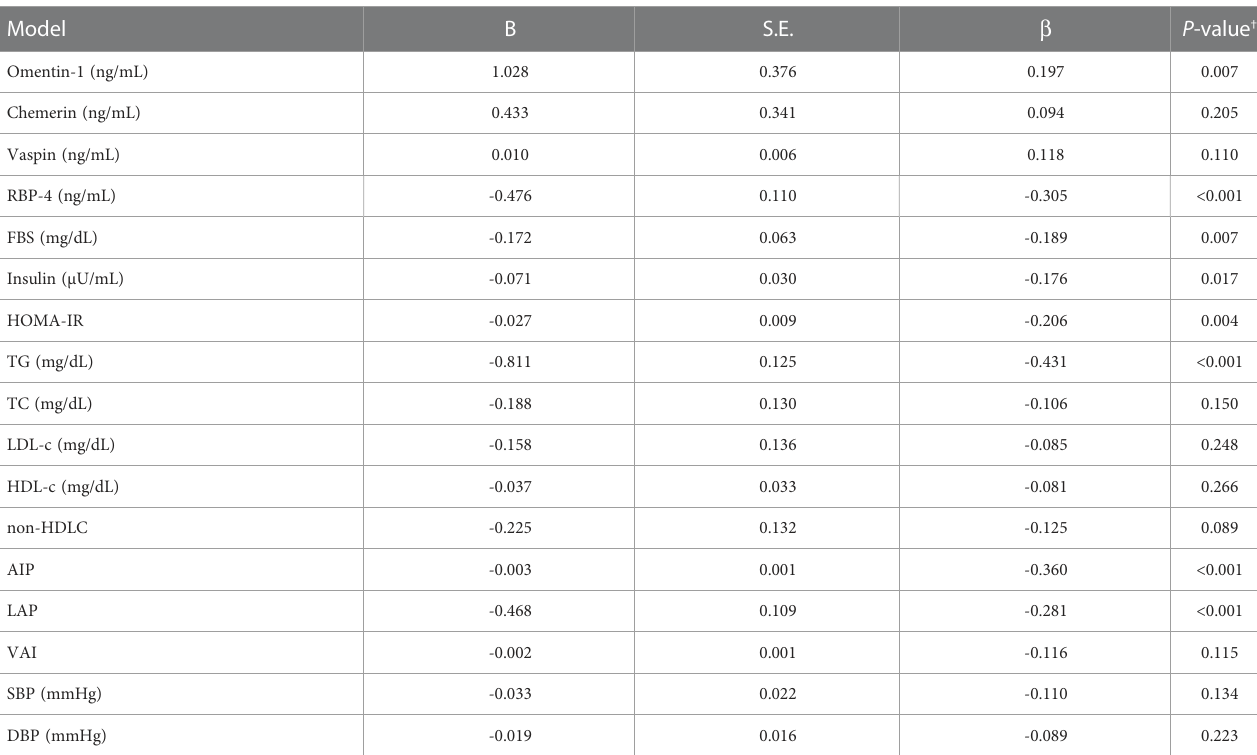
RBP-4, retinol binding protein 4; FBS, fasting blood sugar; HOMA-IR, homeostasis model assessment of insulin resistance; TG, triglyceride; TC, total cholesterol; LDL-c, low-density lipoprotein cholesterol;HDL-c,high-densitylipoproteincholesterol;AIP,atherogenicindexofplasma;LAP,lipidaccumulationproduct;VAI,visceraladiposityindex;SBP,systolicbloodpressure;DBP,diastolic blood pressure; B, unstandardized coef fi cient; S.E., standard error. † Adjusted for age, sex, smoking, physical activity level, and